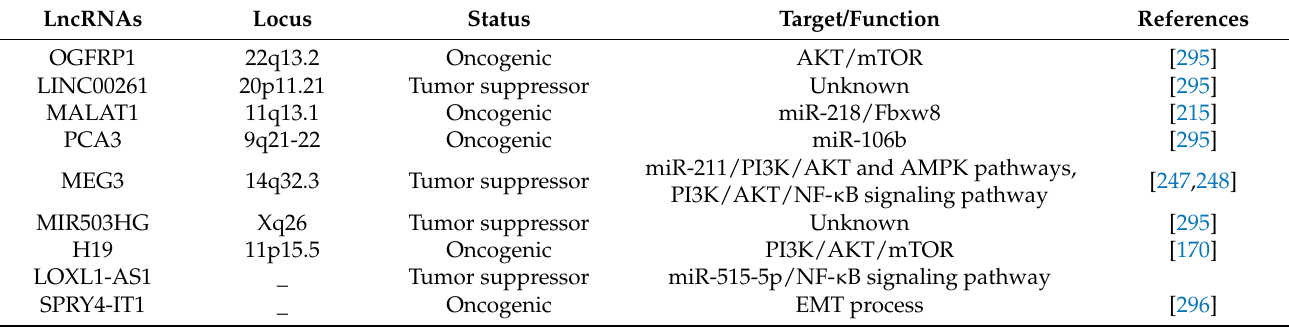
Table 6. LncRNAs involved in proliferation, invasion, apoptosis, migration, metastasis, and drug resistance in